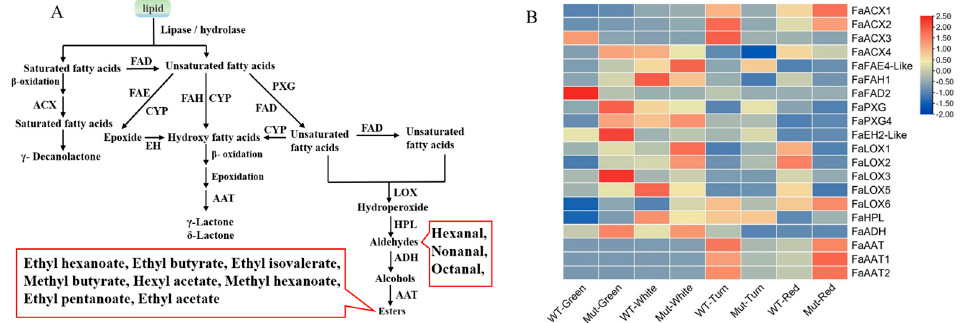
Figure 5. ( A ) Fatty acid pathway. The green box represents the precursor for the fatty acid pathway; the red boxes represent volatile components that play a major role in strawberry aroma (i.e., odor activity values are greater than 1). FAD is fatty acid desaturase; ACX is Acyl-CoA oxidase; FAE is fatty acid elongase; FAH is fatty acid hydroxylase; CYP is cytochrome P450; EH is epoxide hydrolase; PXG is peroxygenase; LOX is lipoxygenase; HPL is hydroperoxide lyase; ADH is alcohol dehydrogenase; AAT is alcohol acyltransferase. ( B ) Expression analysis of biosynthetic genes involved in the fatty acid pathway of ‘Sachinoka’ strawberry and its somaclonal mutant ‘Mixue’ fruit at four developmental stages. FAD is fatty acid desaturase; ACX is Acyl-CoA oxidase; FAE is fatty acid elongase; FAH is fatty acid hydroxylase; EH is epoxide hydrolase; PXG is peroxygenase; LOX is lipoxygenase; HPL is hydroperoxide lyase; ADH is alcohol dehydrogenase; AAT is alcohol acyltransferase.